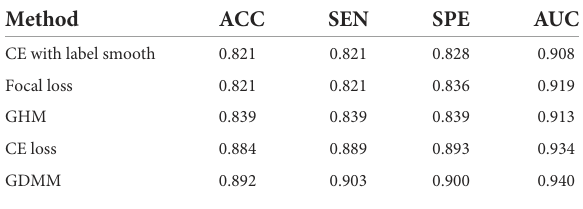
TABLE 8 Quantitative evaluation of ablation analysis for different loss functions in the ADNI